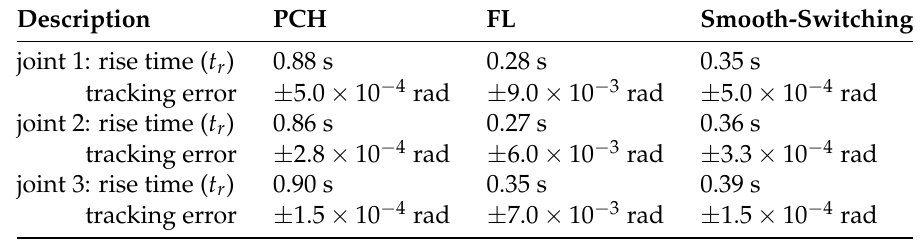
Table 2. Performance indexes of PCH, FL and smooth-switching with q d = 1 + 0.5sin ( π t ) .